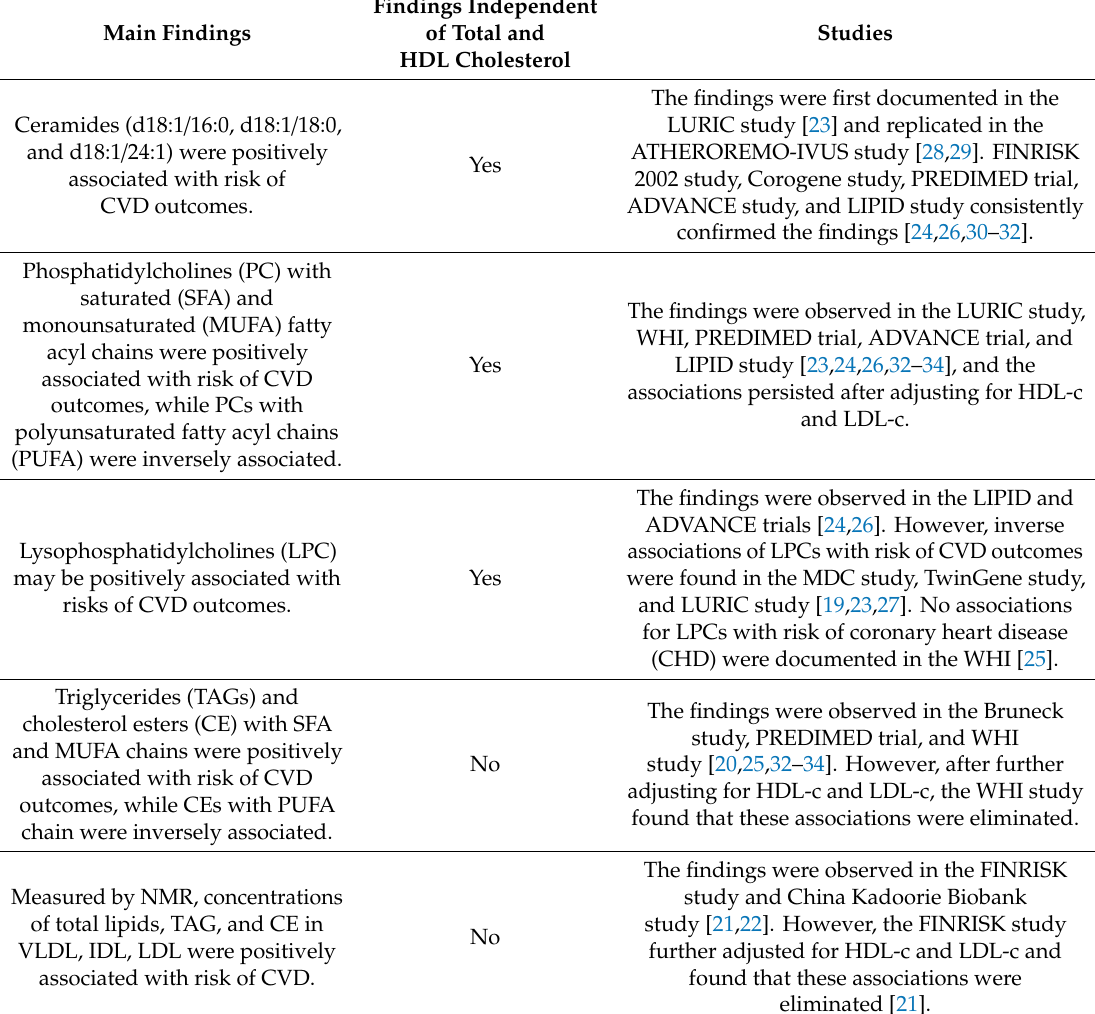
Table 1. Main findings of previous lipidomic studies on the association of lipids with cardiovascular disease